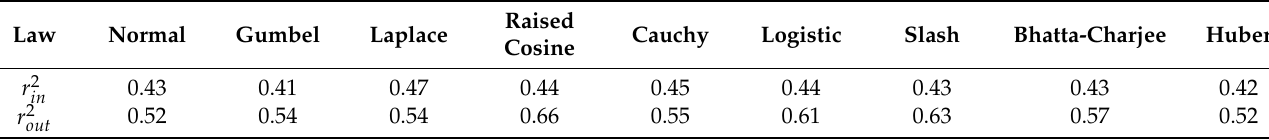
Table 7. Pearson’s correlation coefficients between the distributions with positive slope of groundwater evolution and the theoretical composite pdf ; r 2 applies to measurements inside prediction interval, r 2 applies to measurements outside the prediction interval.